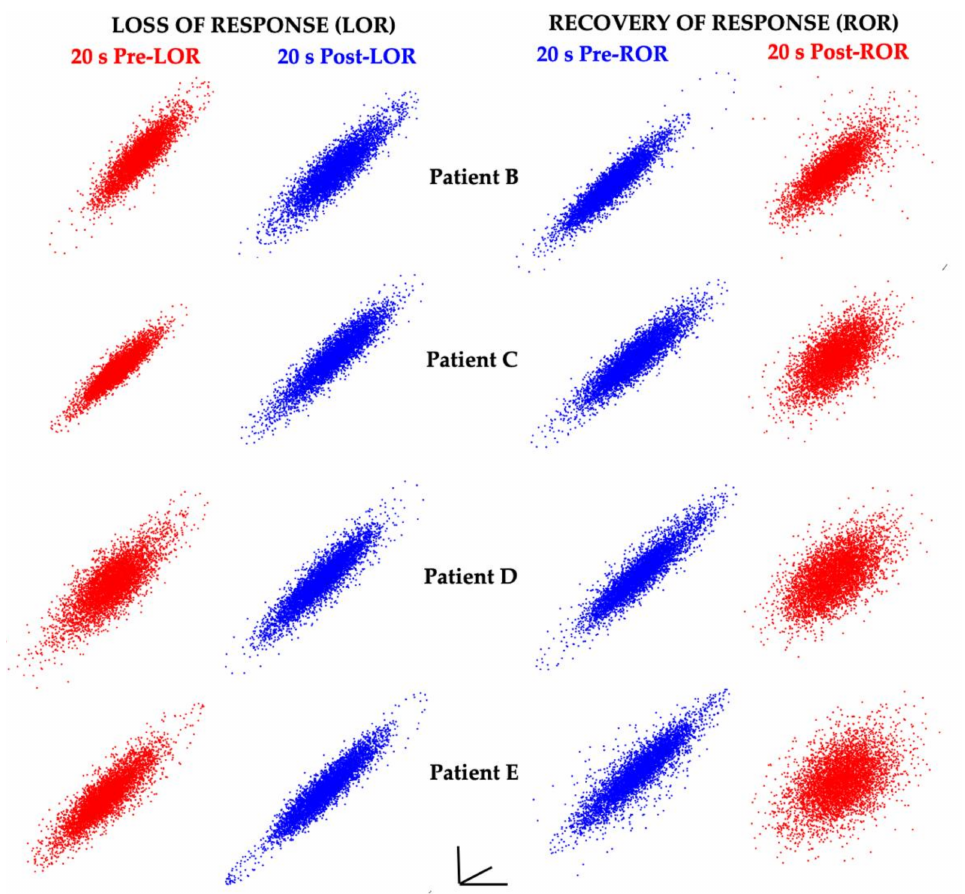
Figure 6. EEG attractors consistently demonstrate shape changes with changes in responsiveness. Attractors from 20 s EEG clips from four patients (the same patients as shown in Figure 5) before and after LOR and ROR when anesthetized with propofol. Awake, responsive states are shown in red, and anesthetized, unresponsive states are shown in blue. Attractors from awake, responsive states are more spherical; whereas attractors from anesthetized, unresponsive states are more ellipsoidal. Attractors are auto-scaled to illustrate the shape changes that occur with LOR and ROR. The axes are shown to demonstrate that these are 2D projections of 3D attractors. Reproduced with permission from Reference